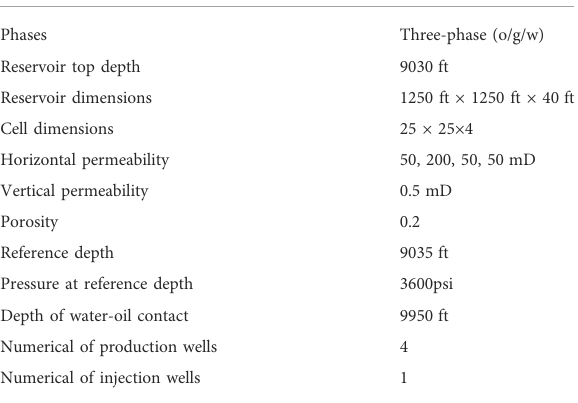
TABLE 1 Reservoir model parameters used in the synthetic